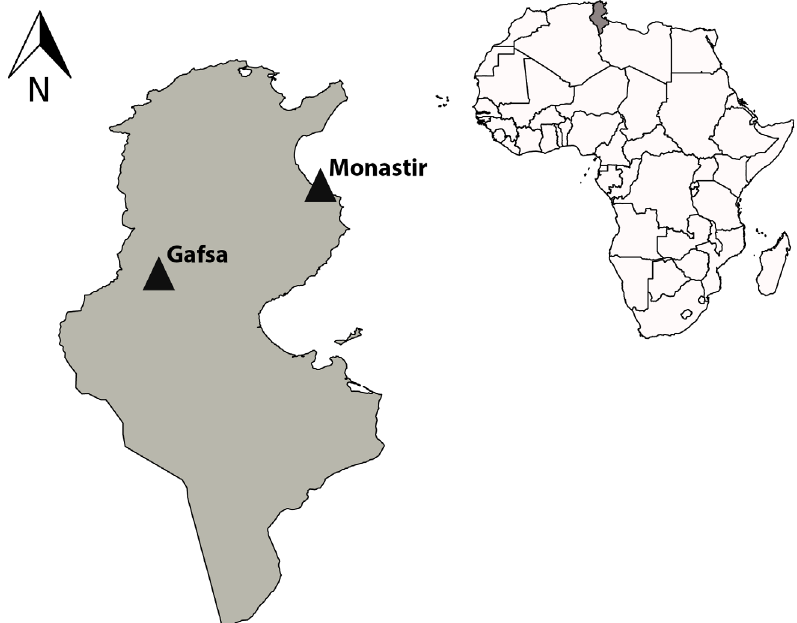
Figure 1. Location of the two study regions on a map of